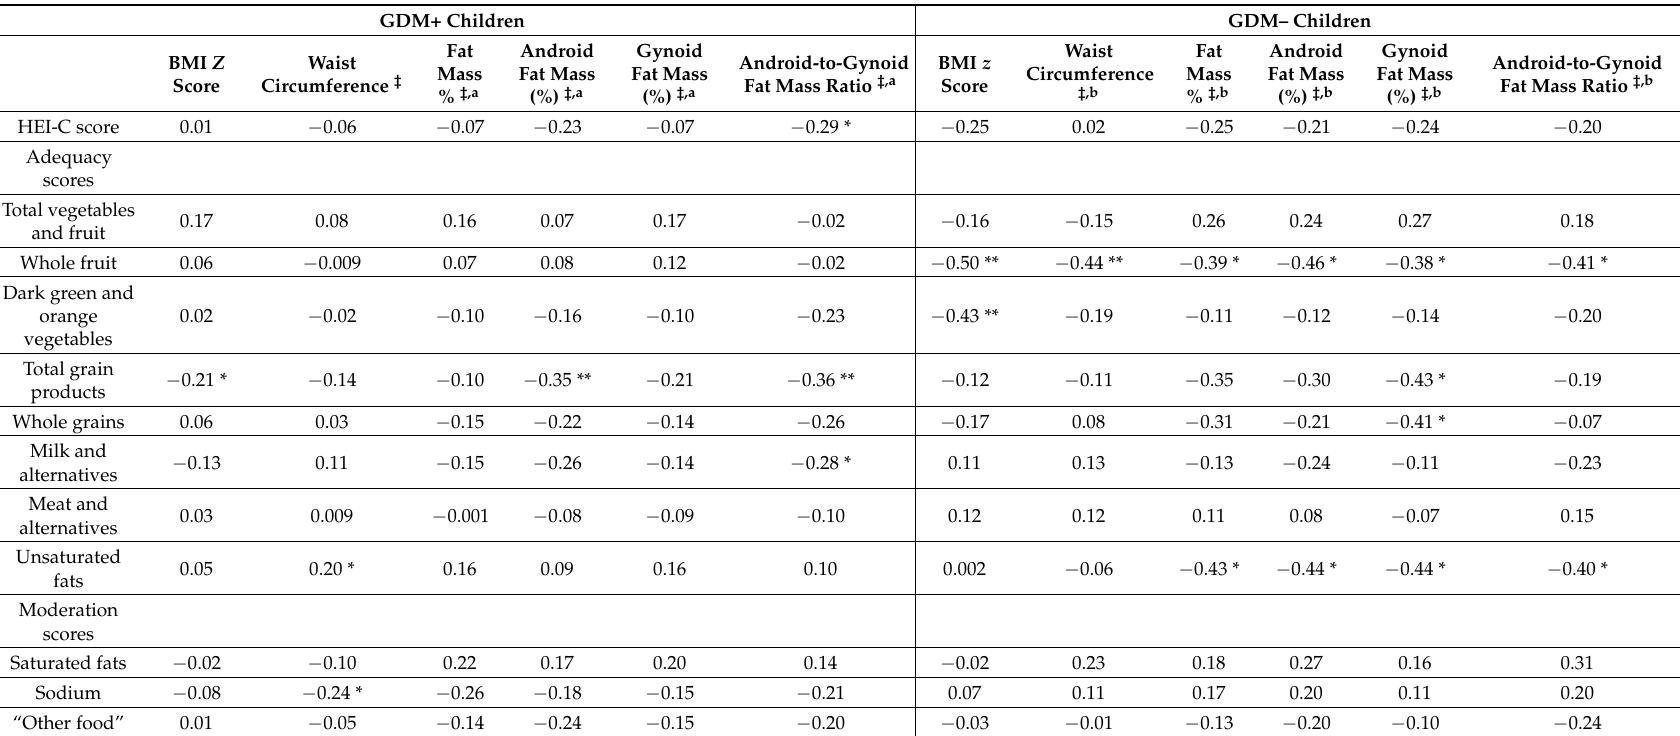
Table 3. Association between diet quality and anthropometric profile of GDM+ and GDM–